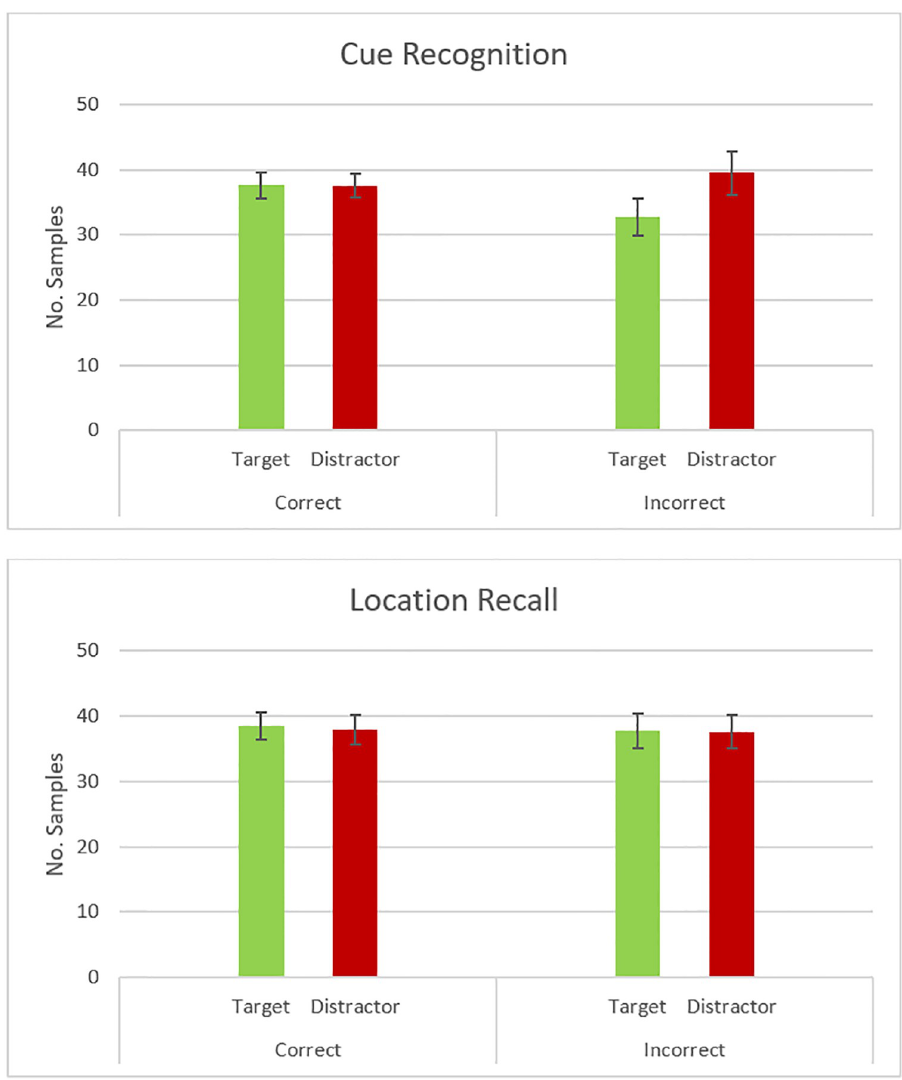
Fig 2. Attention to cues during encoding. The amount of time participants looked at the target or distractor cue during the encoding phase was not related to whether they would later recognize the cue or remember the source location of the cue. The graph shows the number of eye-tracking samples (per trial/per subject) in which gaze was detected as being on the target or distractor cue (and S . E . of the mean). Data are divided according to whether the cue was later recognized or not (top panel) and, if recognized, whether its source location was correctly remembered (lower panel).